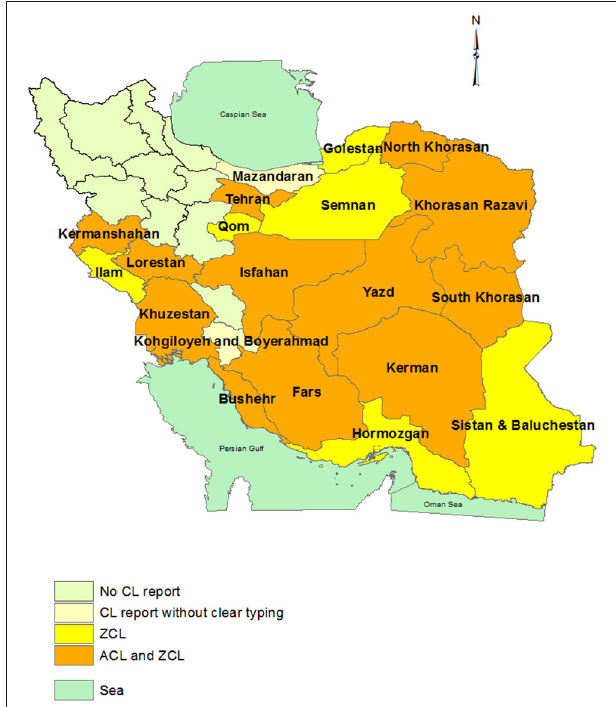
FIGURE 1 | Province-based distribution of ACL and ZCL in Iran. ACL is confined to one or some counties in each province that was not shown here. The maps were generated based on the shape file layers of provinces of Iran and neighboring countries obtained from the DIVA-GIS website (http://www. diva-gis.org/gdata) by using ArcGIS version 10.1